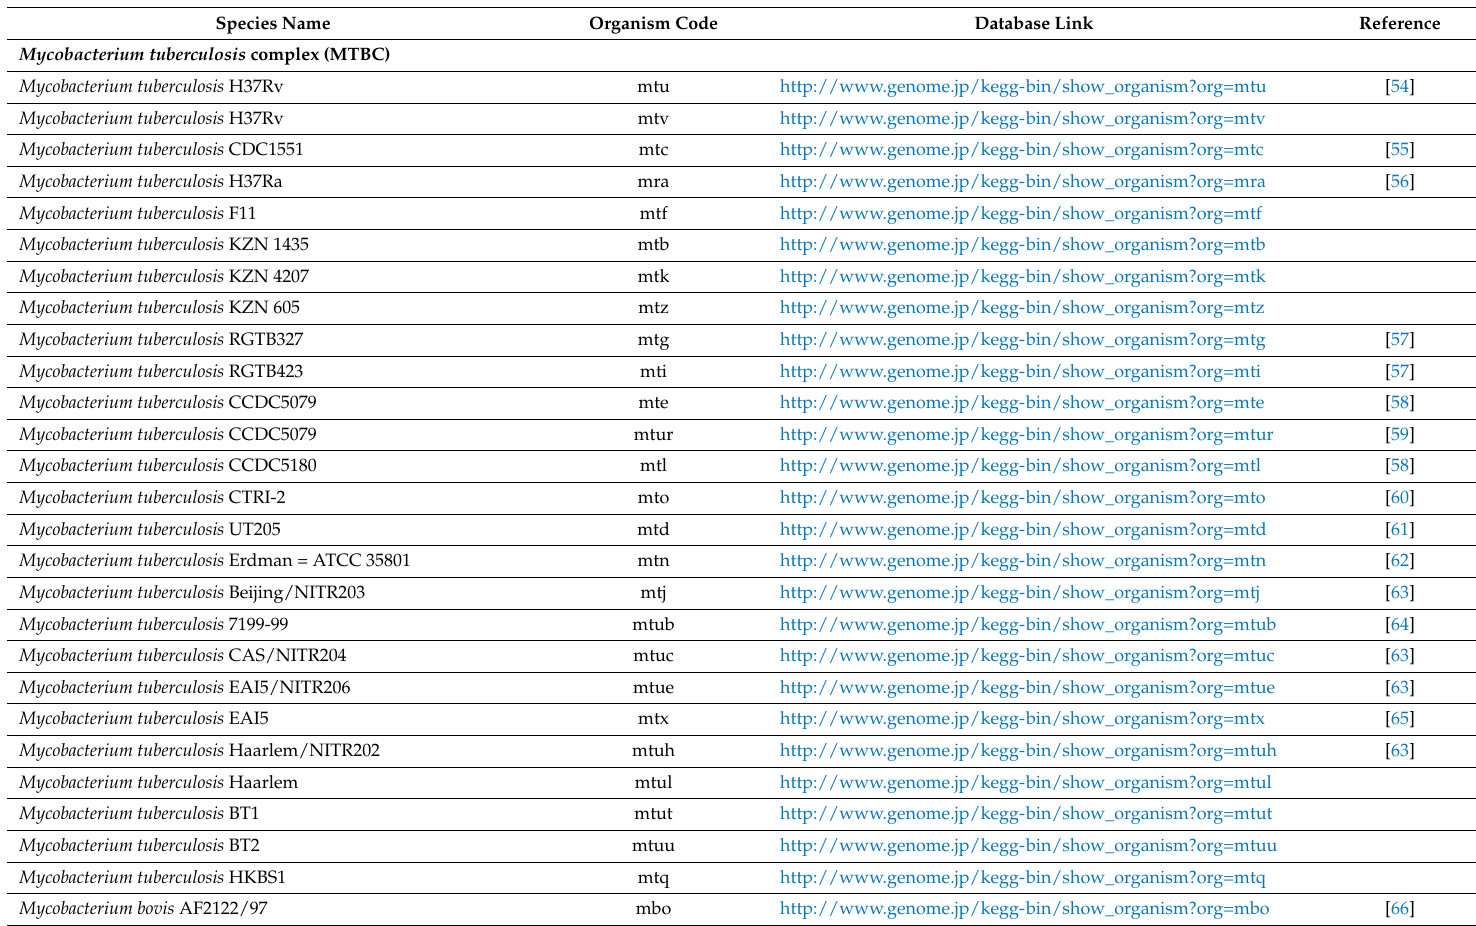
Table 3. List of mycobacterial species and their database links used in the study. For some species, references were not available despite the genome database being available for public use at the Kyoto Encyclopedia of Genes and Genomes (KEGG) database [53] and thus references were not cited for these. Species